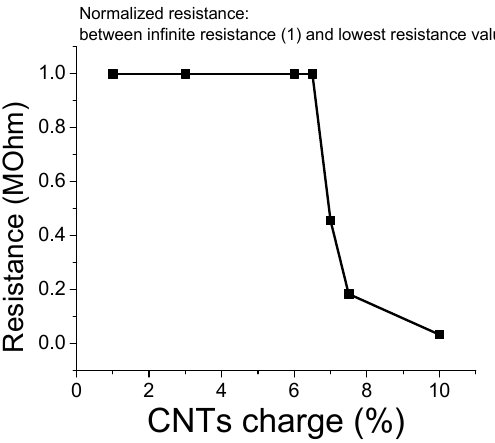
Figure 8. Percolation threshold for MWCNTs dispersion in AMP-functionalized polymer PYR6. In the Y axis an arbitrary range of resistance (in MOhm).